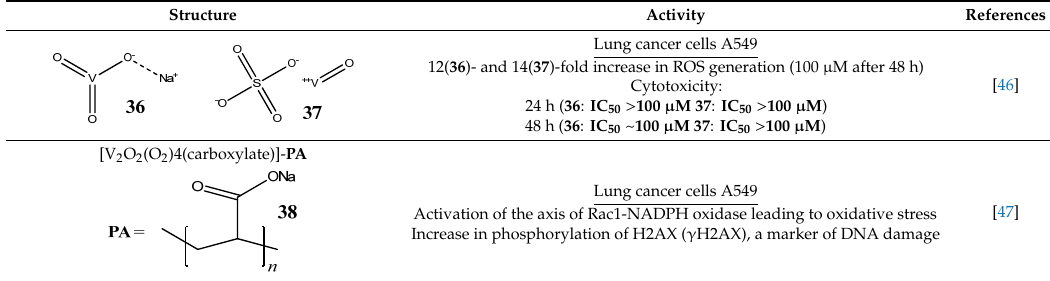
Table 2. Structures and mechanism of action ROS-inducing vanadium compounds (ROS, reactive oxygen species; MMP, mitochondrial membrane potential; GSH/GSSG, reduced/oxidized glutathione). Structure